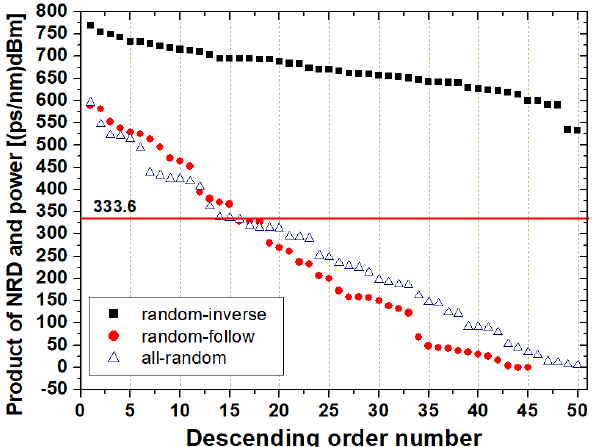
Figure 6. The product of NRD and launch power.